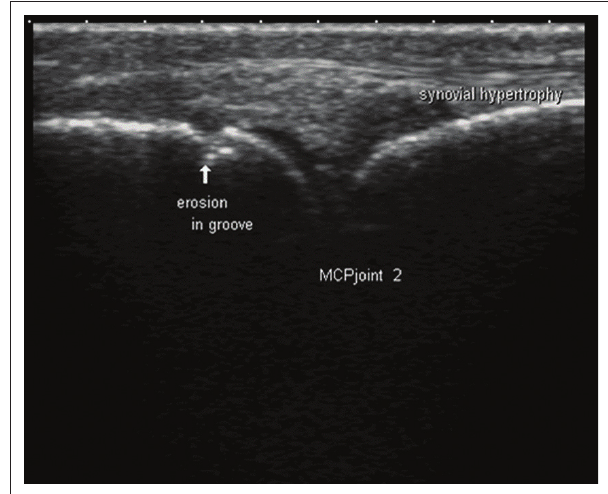
FIGURE 3: Longitudinal ultrasound at the level of the second metacarpophalangeal joint shows synovial hypertrophy with an early